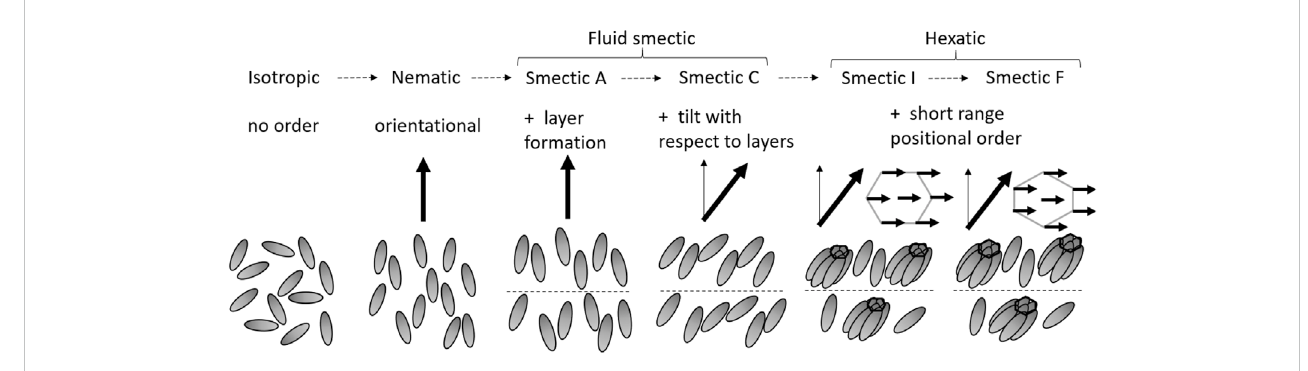
FIGURE 1 Diagram showing the molecular order for different LC phases and the typical sequence of phases with decreasing temperature from left to right. Bold arrows indicate the average molecular orientation, i.e., the